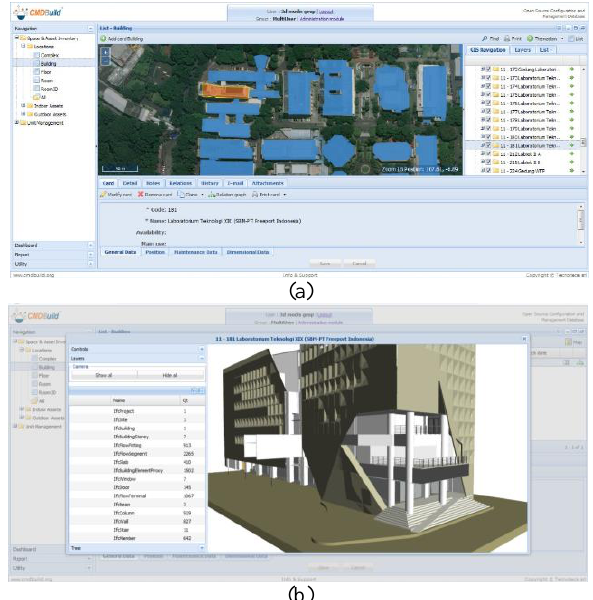
Figure 6. CMDBuild for private user visualization of ITB: (a) 3D map (GIS) and (b) 3D model of each building (BIM)